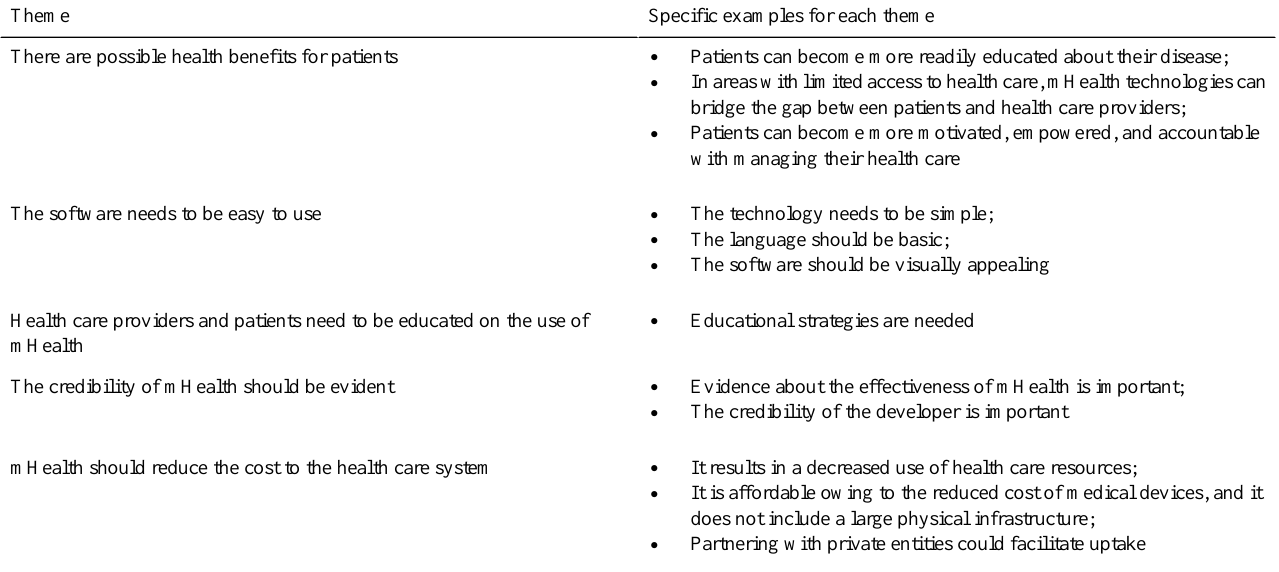
Table 2. Themes with specific examples regarding the facilitators of mobile health (mHealth) adoption.